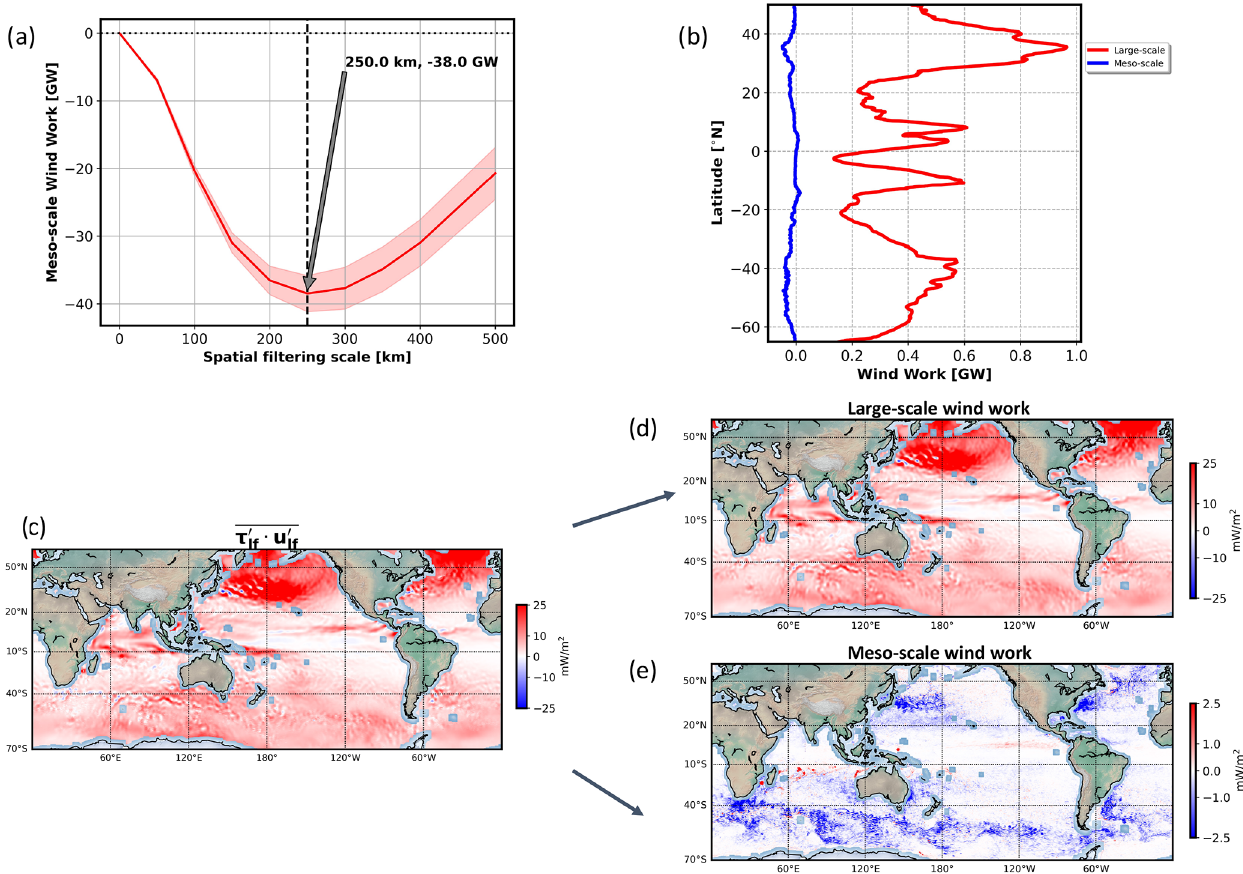
Figure 7. Low-frequency wind work. (a) Partition into positive and negative wind work. L c is defined as the minimum of the blue (COAS) (see Rai et al., 2021 for the calculation of these curves) using 12-month outputs of wind stresses and ocean currents. Interpretation of L c is that all wind work with scales smaller (larger) than L c is negative (positive). (b) Zonally integrated low-frequency wind work with scales larger (red curve) and smaller (blue curve) than L c from COAS during the period April–May–June. (c, d, e) Distribution in physical space of the (c) low-frequency wind work from COAS for scales larger (d) and smaller (e) than L c during the period April–May–June.